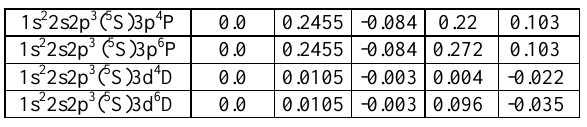
with the 1s 2 shell in the same way as in lithium-like ions. of the second and third shells were chosen. The Table 1. Parameters of one-electron excited states of N- like ions Table. 2. The same table shows a comparison of the calculation with the experimental data the handbooks [12]- [13]. As seen from the comparison, the theoretical and measured values of electronic energies and fine splitting are in good agreement. The fine splitting 1s22s22p23s 4P5/2 –1s22s22p23s 4P1/2 is equal to the taking into account the effect of the third shell electron on the energy levels of the second shell. As the principal quantum number n of the third shell electron increases, carbon-like ions. The comparison of data shows that probably measured with a large error. Table 2. Comparison with experiment of the calculated energies (in eV) of 1s 2 2s 2 2p 2 ( 3 P)3s 4 P 5/2 states of N-like ions and fine